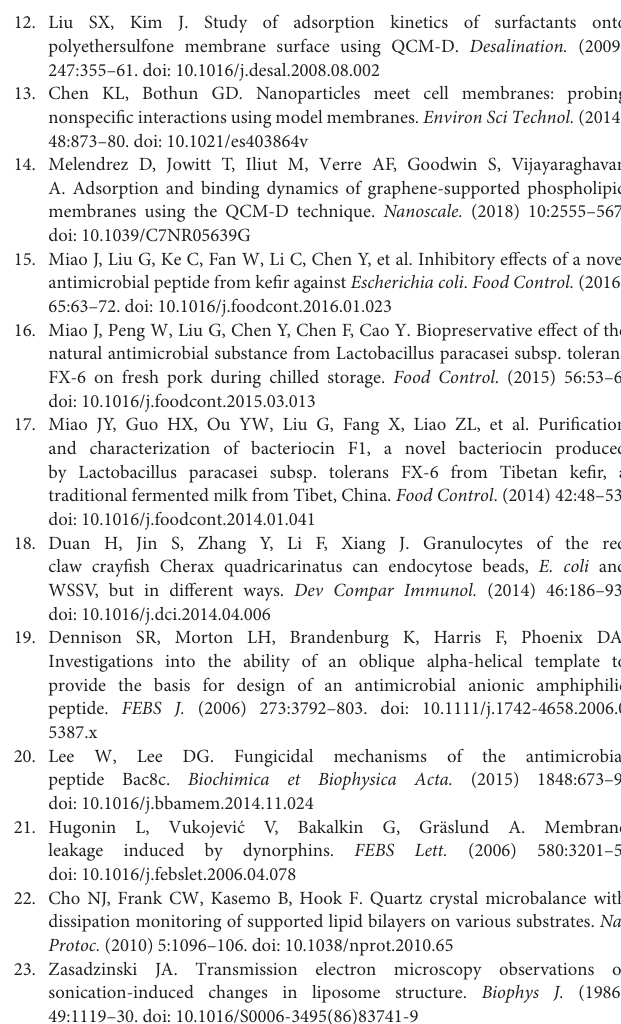
Supplementary Figure 1 | Fluorescence working curve of